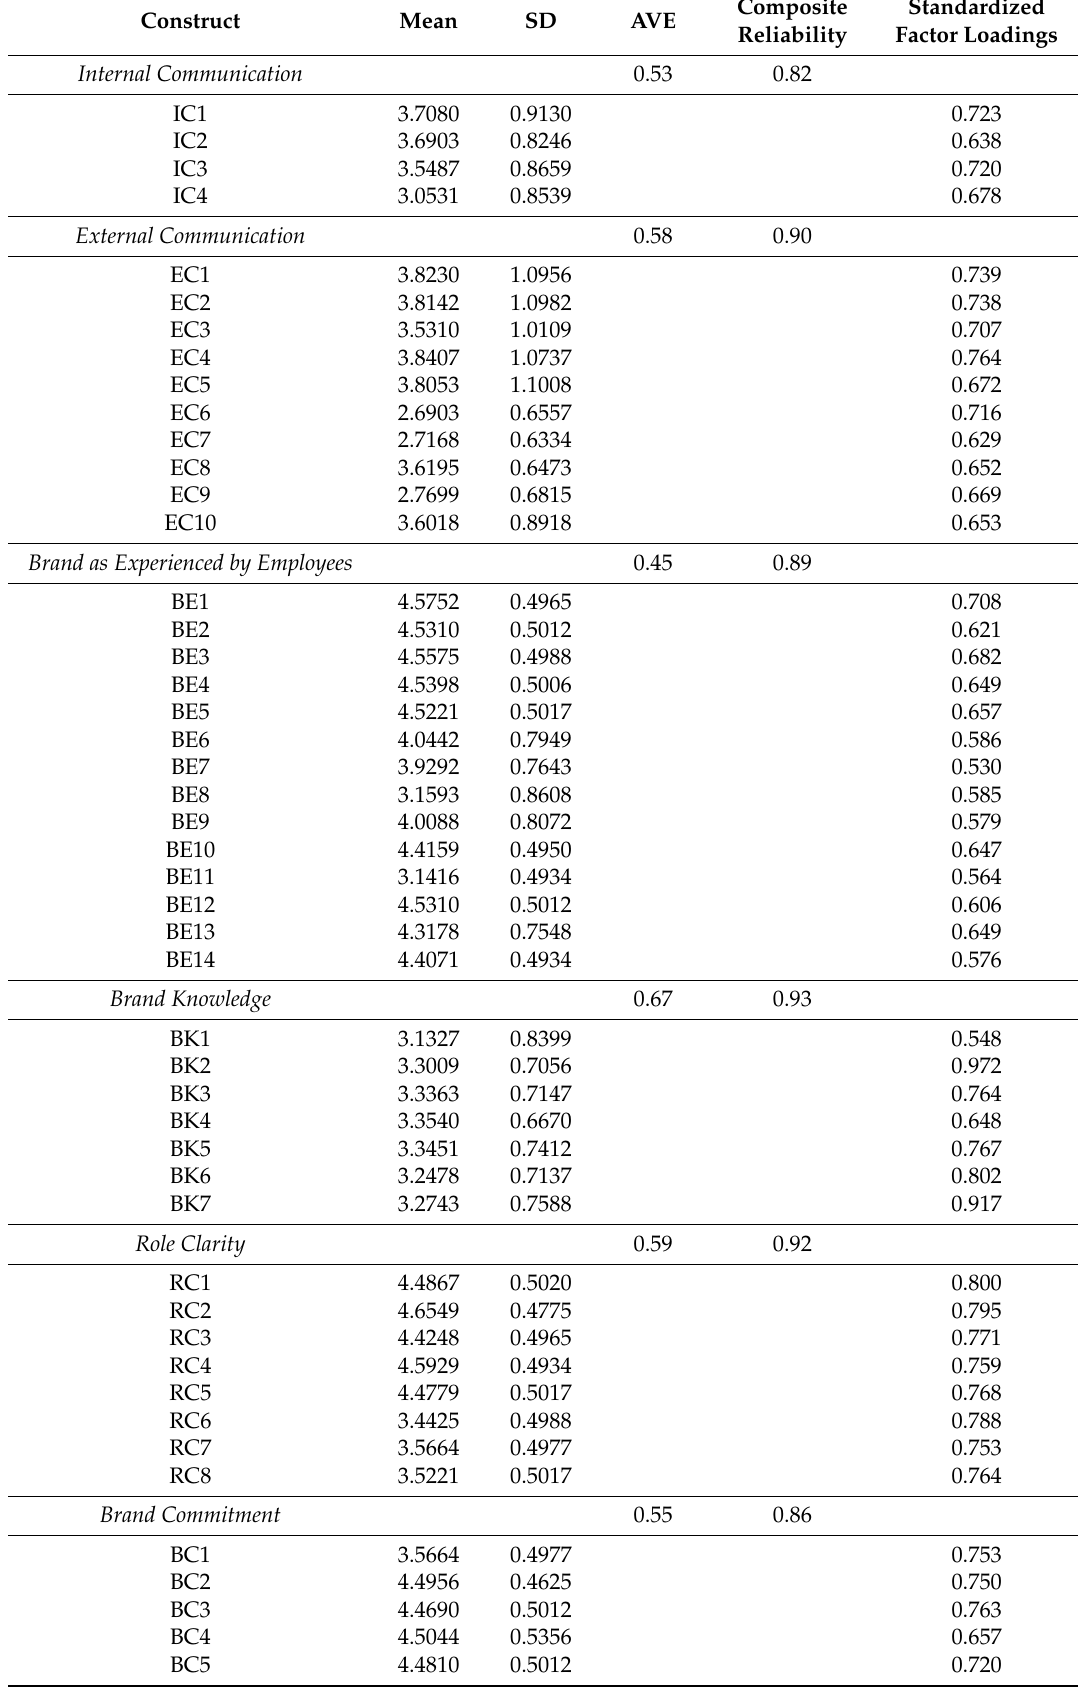
Table 3. Measurement model